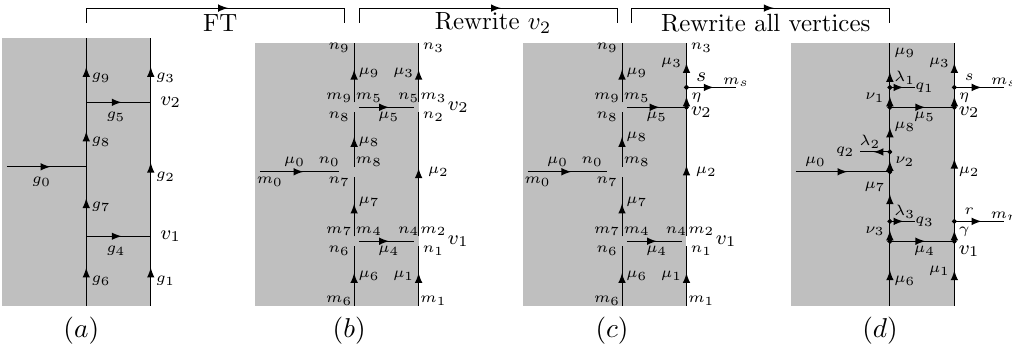
Figure 2 . Basis transformations of the Hilbert space of the extended QD model. (a) A group-basis state on a part of the original lattice (cid:0). (b) Basis states in the Fourier transformation of (a). (c) Basis states obtained by rewriting vertex v 2 in (b). (d) Basis states obtained by rewriting all vertices in (b), obtaining a new lattice